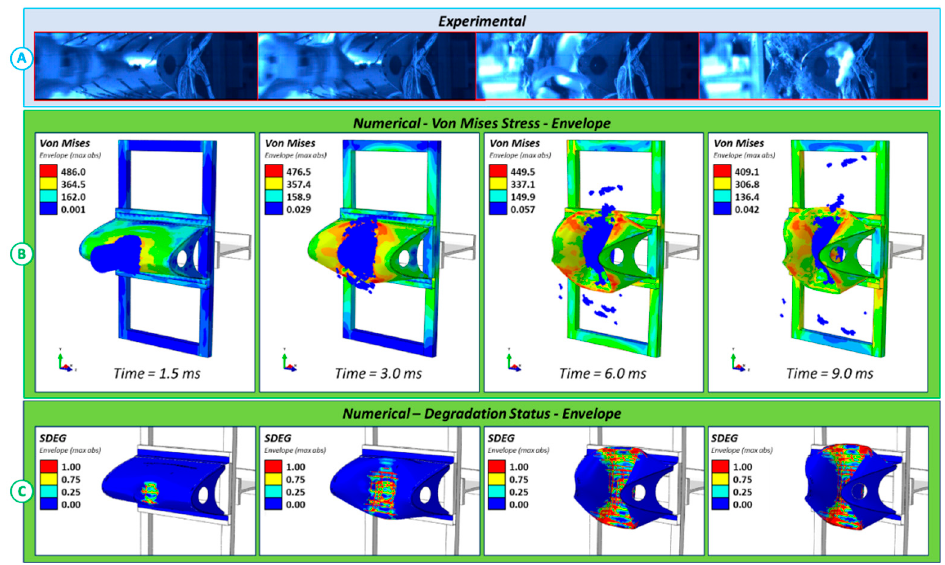
Figure 3. Results at different time steps. ( A ) Experimental deformations; ( B ) numerical—Von Mises stress; ( C ) numerical—damage status.